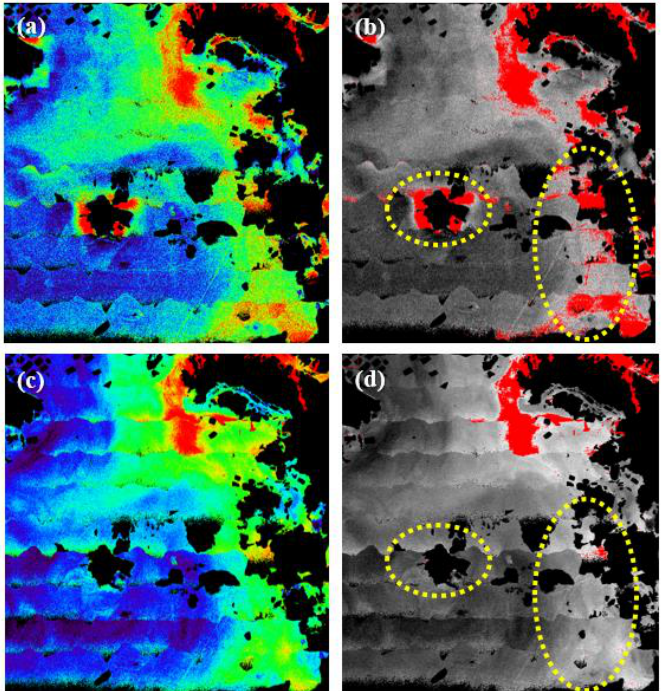
Figure 13 . Red tide detection based on (a, b) fluorescence line height analysis at 680 nm and (c, d) ratio analysis between 547 and 575